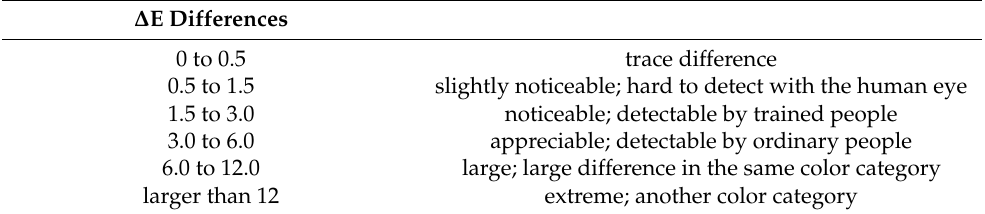
Table 1. Differences between ∆ E